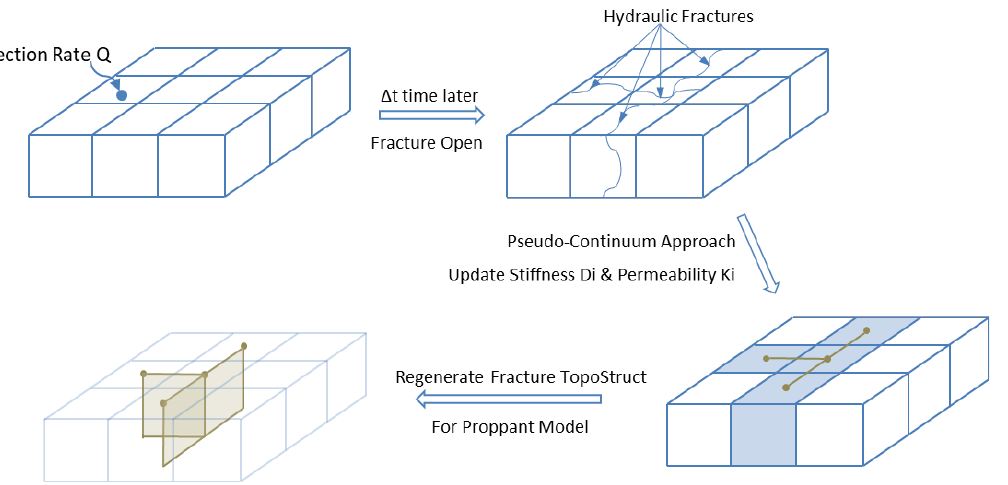
Figure 3—A schematic illustration of the topological structure of